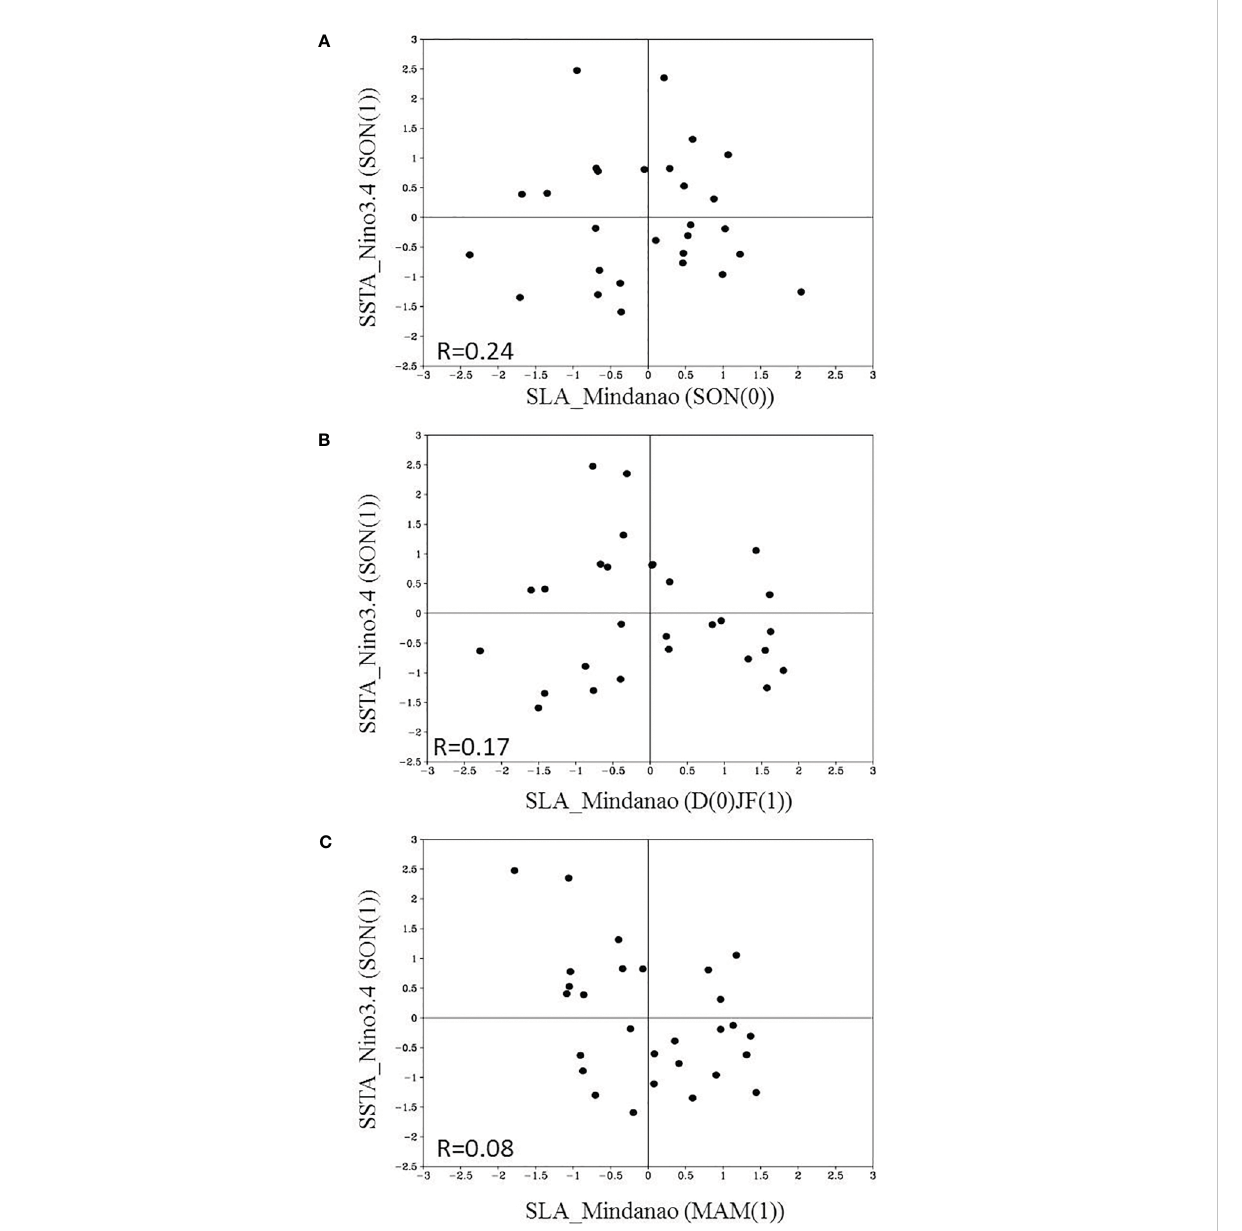
FIGURE 8 The relationship between equatorial Rossby waves at the Paci fi c Ocean western boundary and the Niño3.4 index one year later. Scatter plot of the fall Niño3.4 index (°C) with the preceding (A) SON, (B) DJF, and (C) MAM SLA (decimeter) off the east coasts Mindanao (127°E-135°E, 5°N-8°N) during 1993-2020. Correlation coef fi cients in the third quadrant are shown in the lower left of each